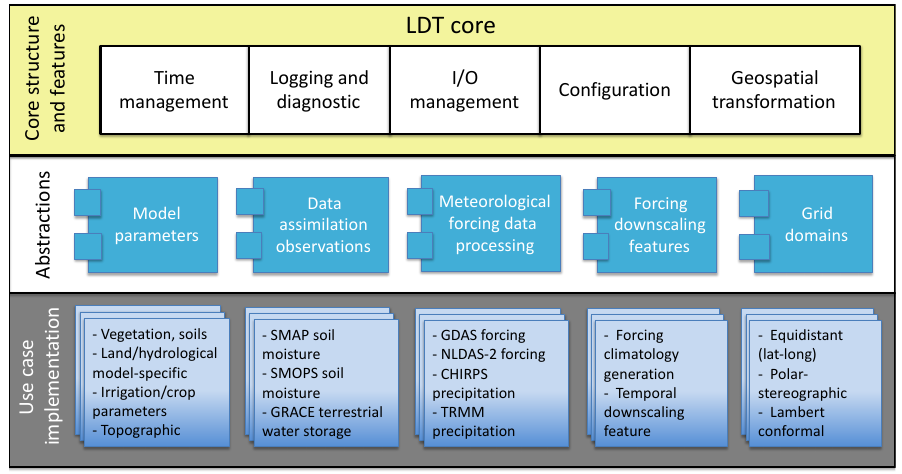
Figure 2. Schematic of LDT’s main software architecture, showing the various core structures, abstraction layer, and use case implementa- tions.